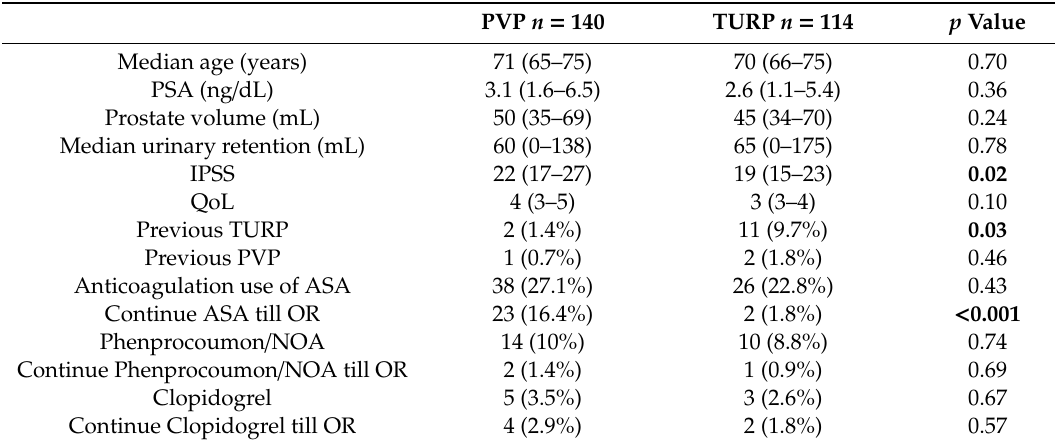
Table 1. Patient baseline